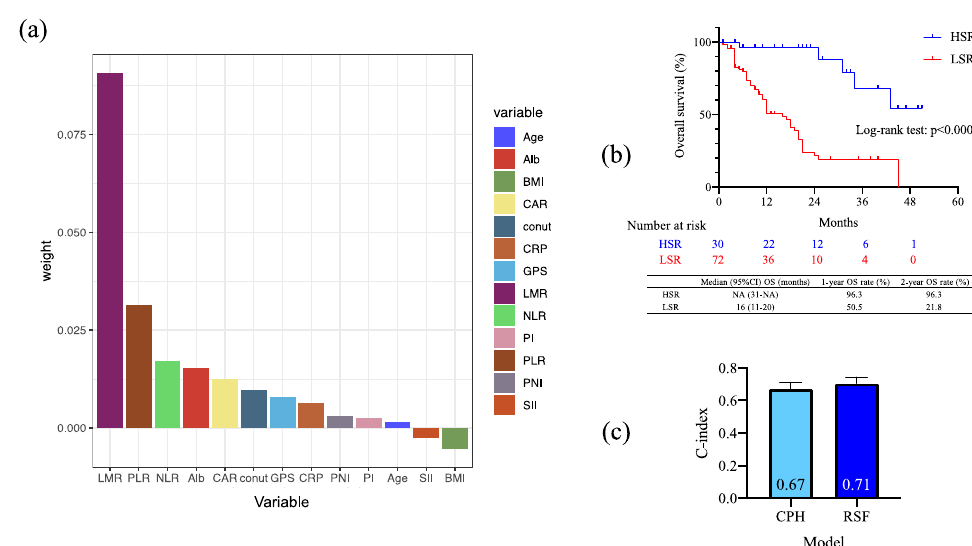
Figure 4. ( a ) The analysis of the importance of included factors using random survival forest (RSF). LMR had the highest weight of all factors. ( b ) Kaplan–Meier survival curves and log-rank tests by predicted survival rate using the RSF model. There was a significant difference between the two groups. ( c ) Comparison of c-index by model. RSF had a c-index of 0.71, while the cox proportional hazard model had a c-index of 0.67, which was slightly higher for RSF.